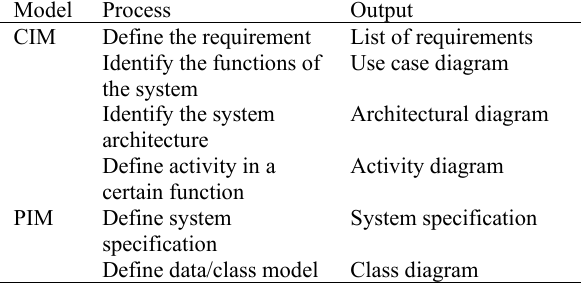
Table 3. Process and Output in Modelling